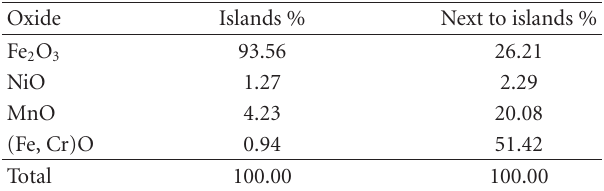
Table 2: EDX spectra results of islands and next to islands for AISI 304 at T = 1000 ◦ C.